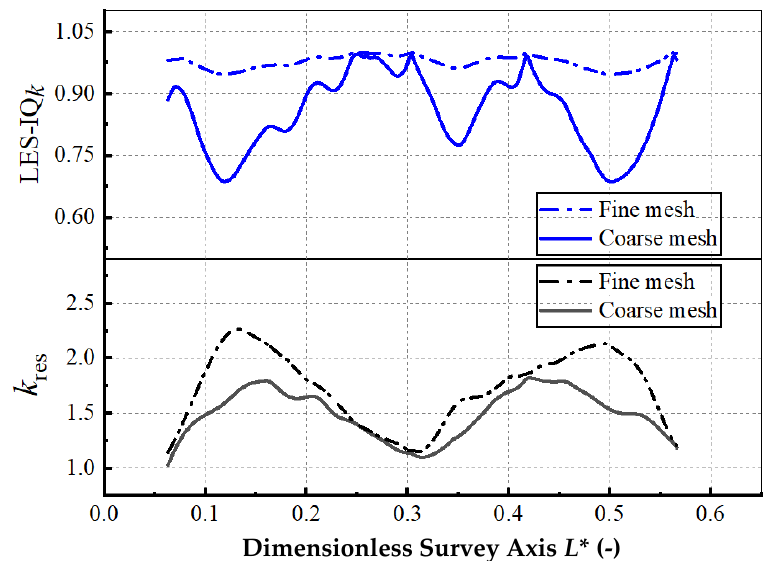
Figure 3. Turbulent kinetic energy and LES_IQ of two sets of grids on W2. ( L * = L W2 / R throat , where L W2 is the length of Line